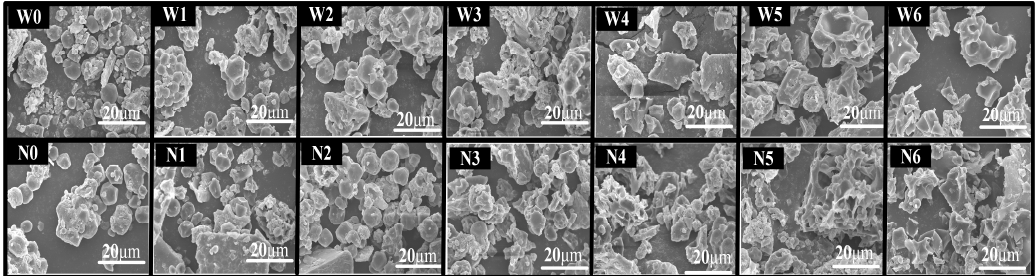
Figure 5. Micrographs of flours in uncooked and cooked proso millet grains. W0–W6: Uncooked and cooked (5, 10, 15, 20, 25, and 30 min) waxy proso millet grains, respectively; N0–N6: Uncooked and cooked (5, 10, 15, 20, 25, and 30 min) non-waxy proso millet grains, respectively.